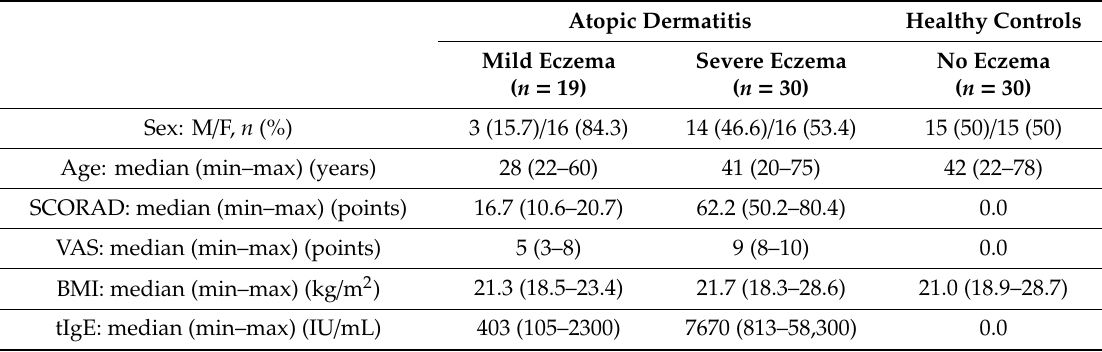
Table 1. Characteristics of mild and severe atopic dermatitis patients. Atopic Dermatitis Healthy